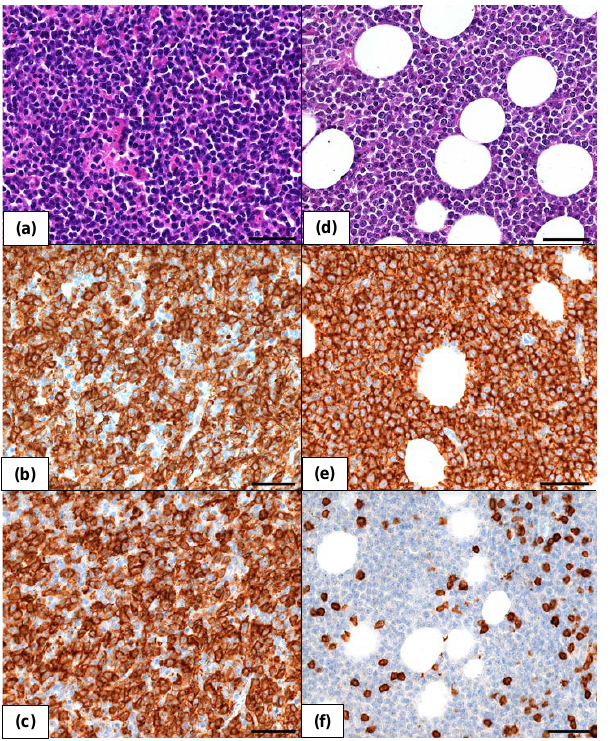
Figure 3. Gross findings in animals 1 and 2. (a) Mucosal surface of the opened stomach of animal 1 with a focal tumorous mass in the gastric wall is shown. (b) In animal 2 an extensive white tumorous mass was present in the bladder neck region obstructing the ureters in their orifice regions (arrows).